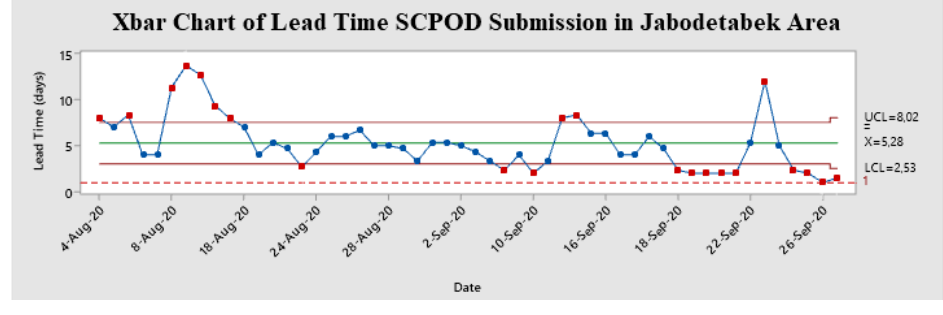
Figure 3: Control Chart of Late SCPOD Submission in Jabodetabek Area